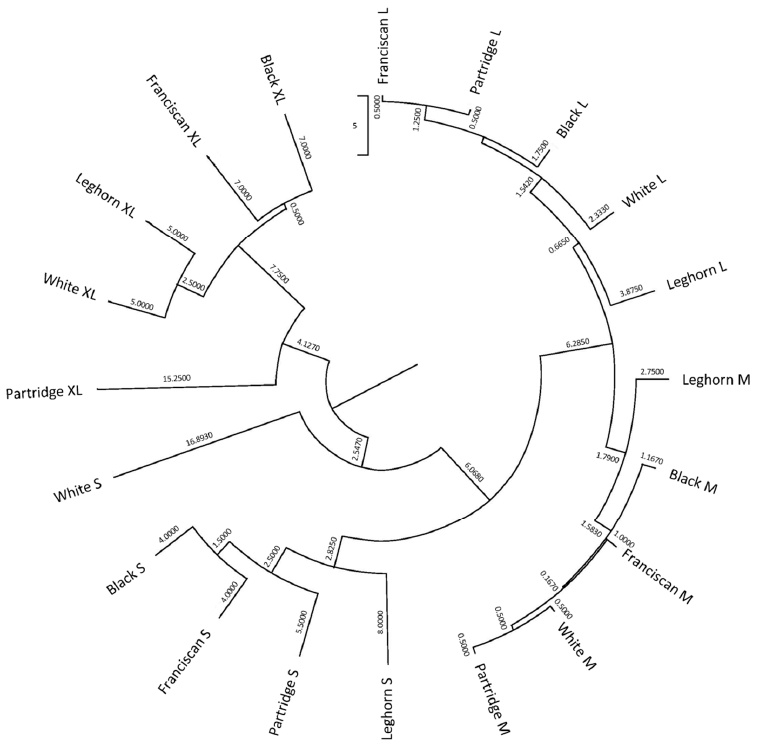
Figure 2. Cladogram constructed from Mahalanobis’s distances between commercial quality clas- sification categories and laying hen genotypes.